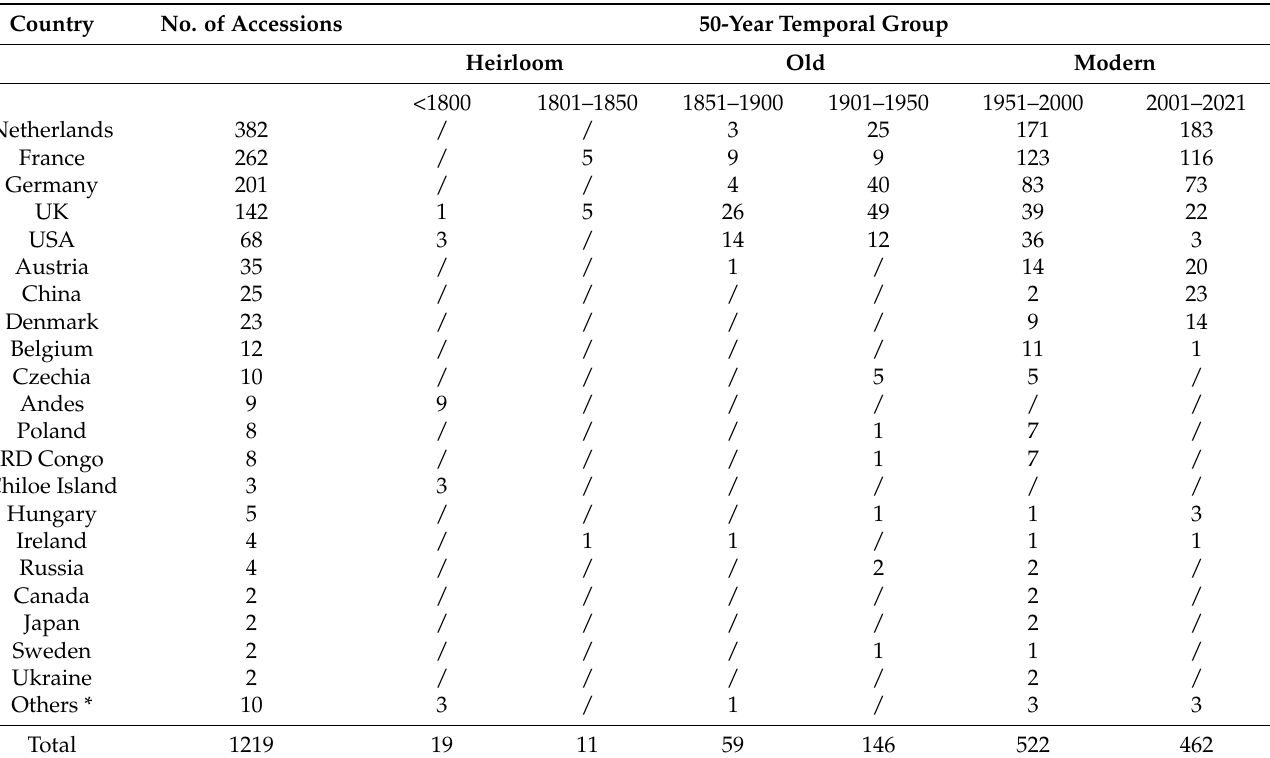
Table 1. Summary of potato accessions number registered in the study with respect to country of origin and date of